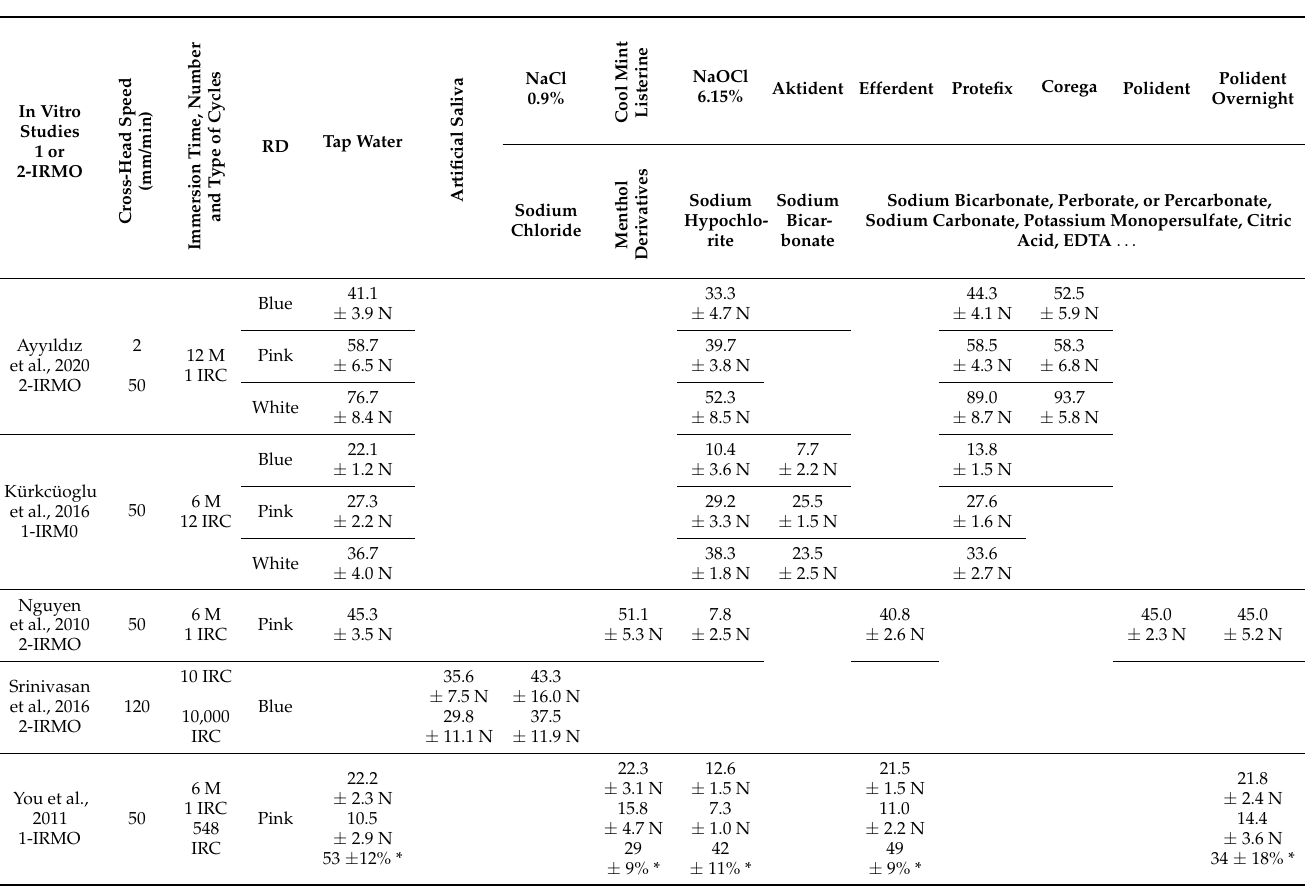
Table 5. Effects of denture cleansing solutions on the initial retention (N) and the retention loss (%) of Locator ® attachment